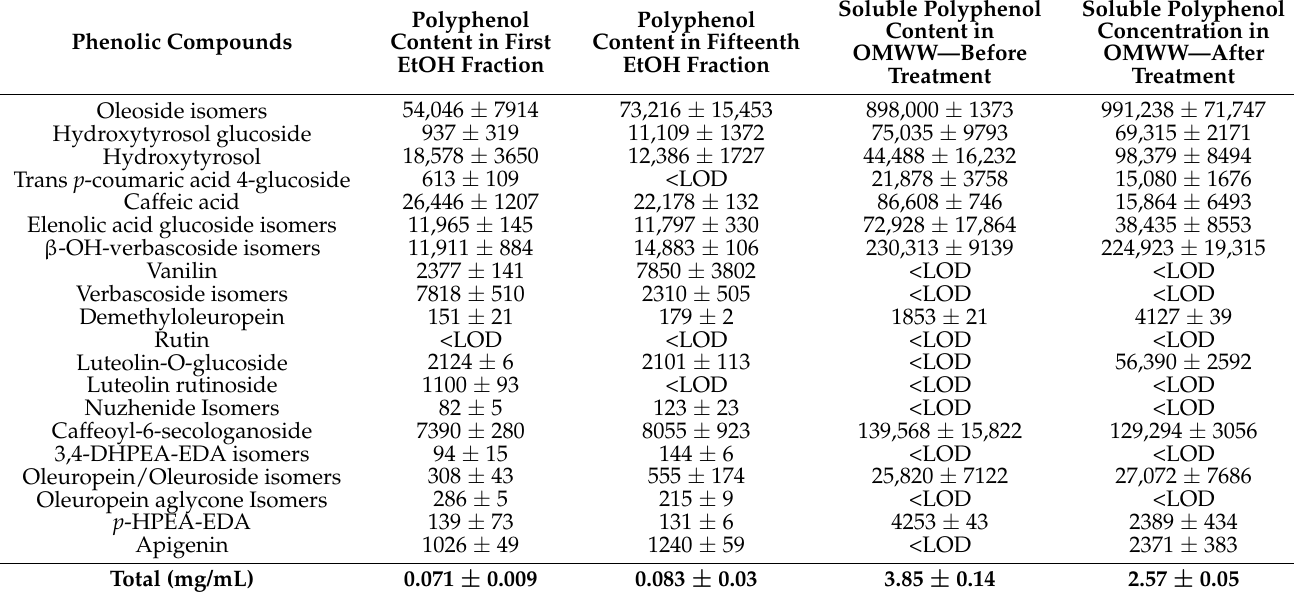
Table 6. Polyphenol quantities for fifteen subsequent treatments of OMWW with Fe 3 O 4 particles modified with sodium dodecyl sulphate. The particles were thereafter desorbed in EtOH. Total concentrations of polyphenolic compounds are quantified in mg per mL of OMWW; individual compounds are semi-quantified (using counts from the MS